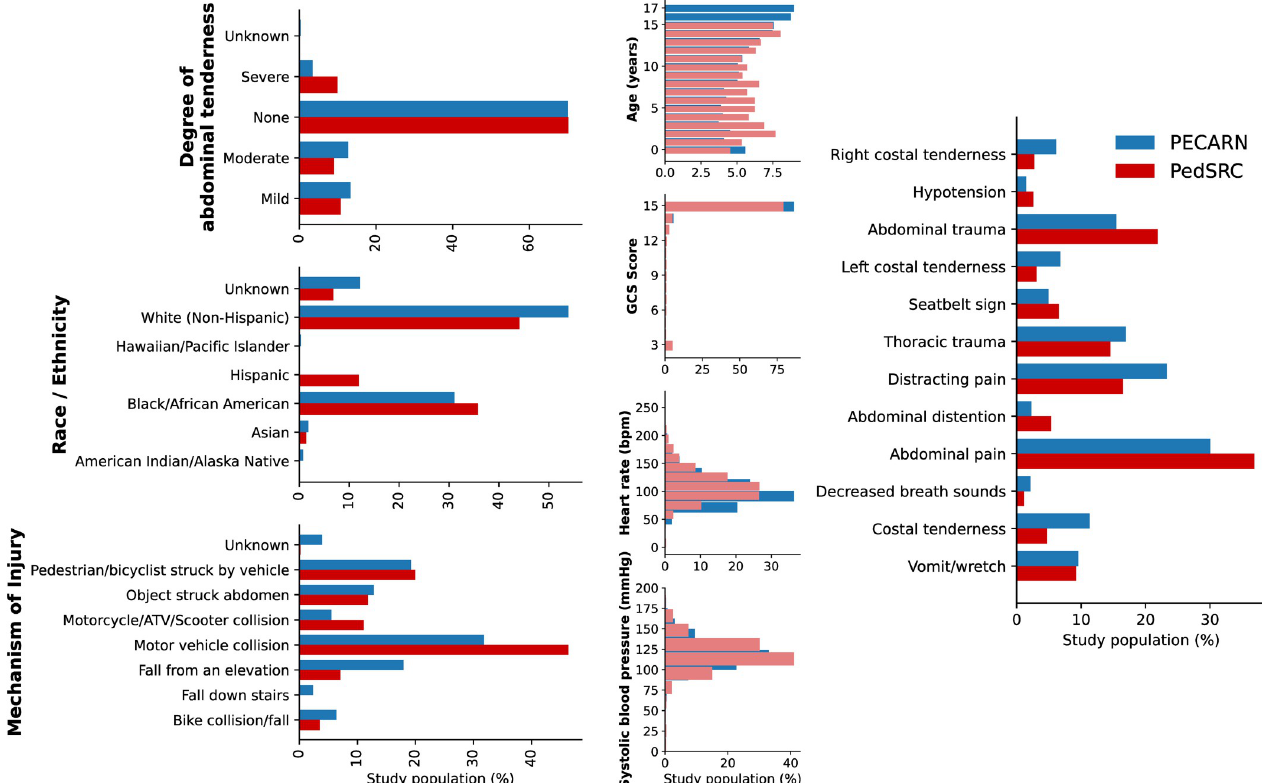
Fig 2. Matched demographic and predictor variables from PECARN and PedSRC datasets visually represented for overall distributions.